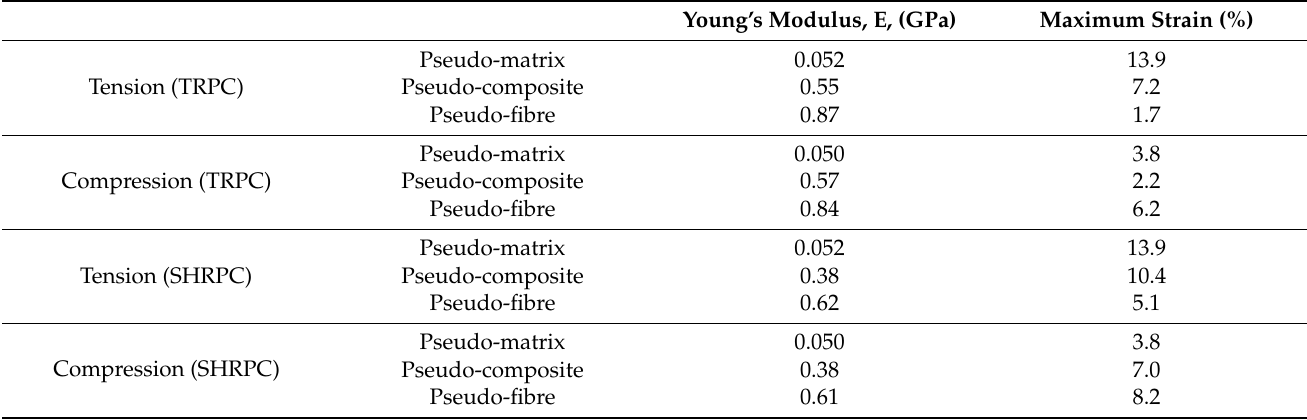
Table 4. Comparison of Young’s modulus and maximum strain values for TRPC and SHRPC in tension and